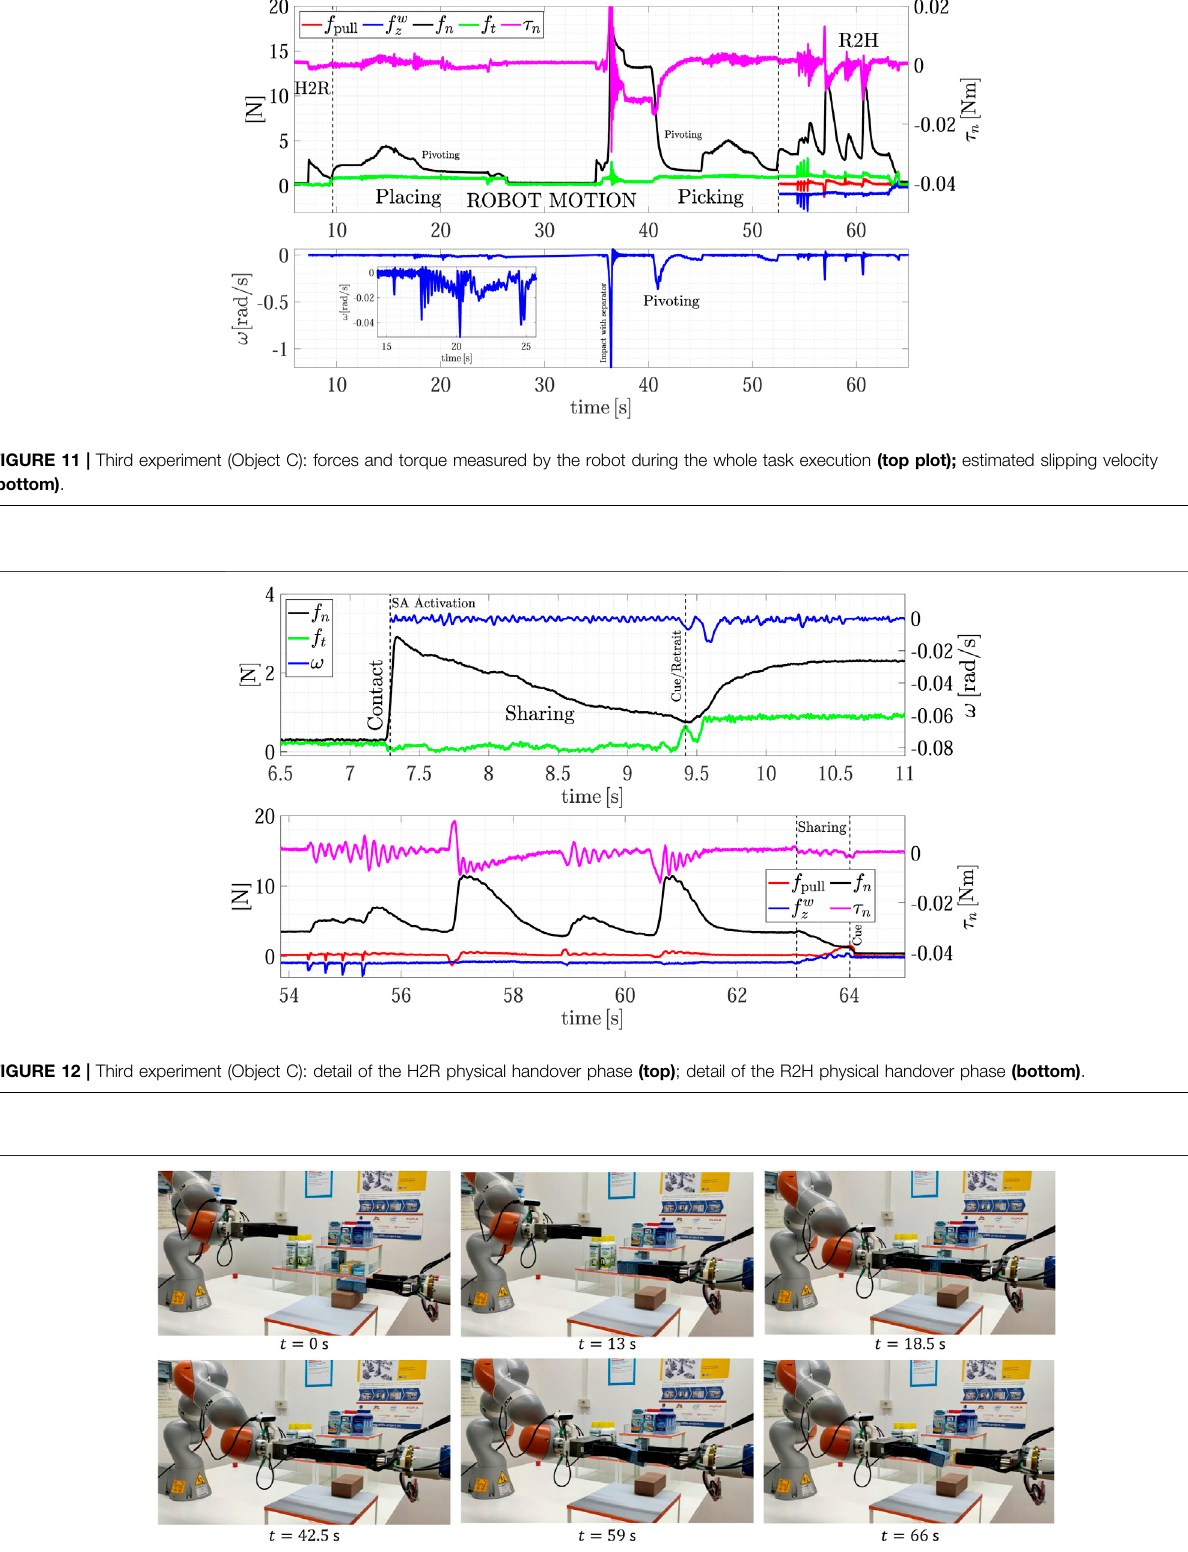
FIGURE 13 | Fourth experiment (object C): R2R